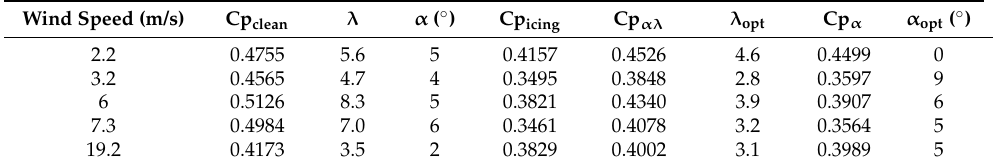
Table 2. Results summary of the performance analysis for a wind turbine with and without icing (adopted from [34]). The results are presented for a clean turbine (Cp clean ), a turbine under icing conditions (Cp icing ), a turbine under icing conditions with pitch control (Cp α ), and a turbine under icing conditions with pitch and tip-to-speed ratio control (Cp αλ ).